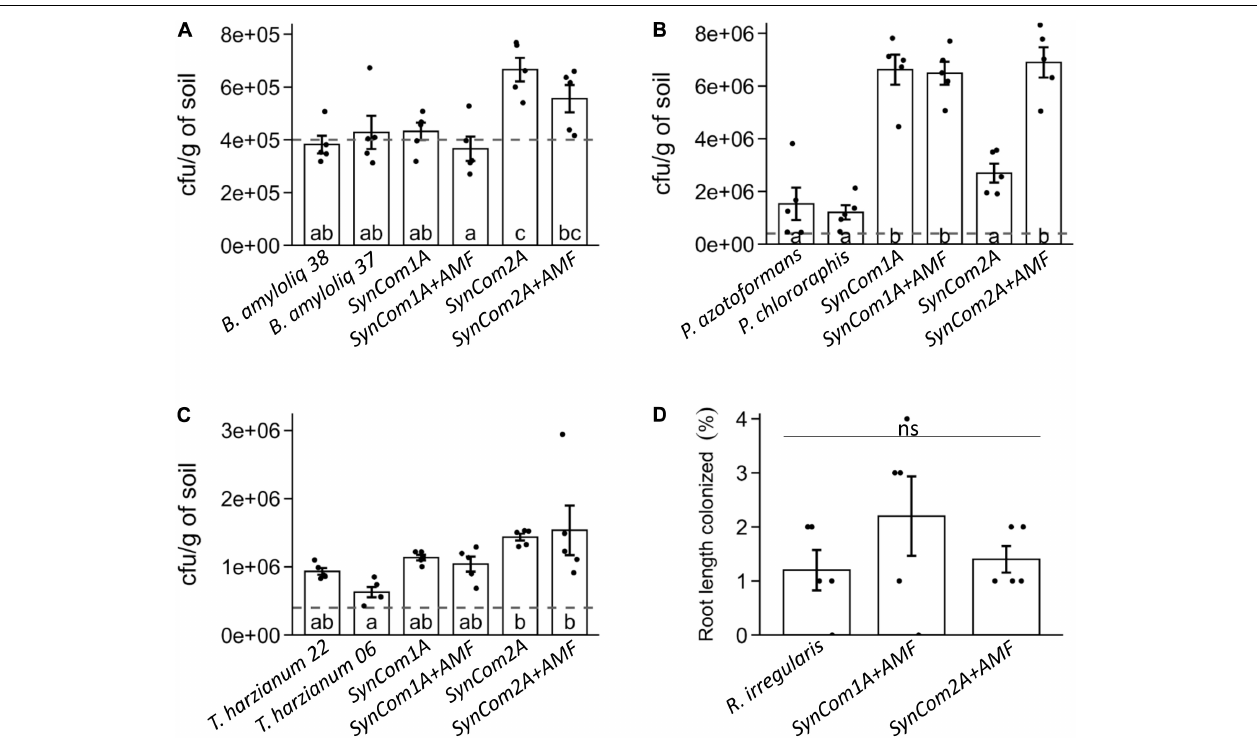
FIGURE 3 | Rhizospheric soil colonization by (A) Bacillus spp., (B) Pseudomonas spp., and (C) Trichoderma spp., expressed as cfu/g of soil, and (D) mycorrhizal colonization by Rhizophagus irregularis represented as the percentage of root length colonized by the fungus. Plants were inoculated at sowing with the individual or consortia treatments (see Supplementary Table 2 ) and grown for 15 days. +AMF indicates consortia co-inoculated with 1,000 spores/plant of R. irregularis. Bars represent mean ± SE. Dashed lines represent the initial concentration inoculated for each microorganism (4 × 10 5 cfu/g of soil). Treatments not sharing a letter in common are significantly different based on the general linear model and Tukey honestly significant difference (HSD) test ( p < 0.05, n =